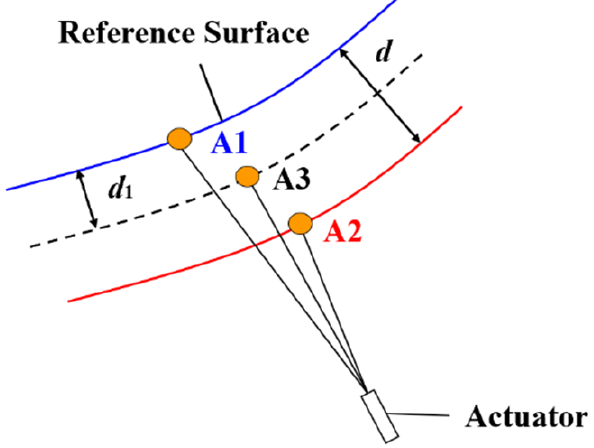
Figure 6. Schematic representation of iterative steps.